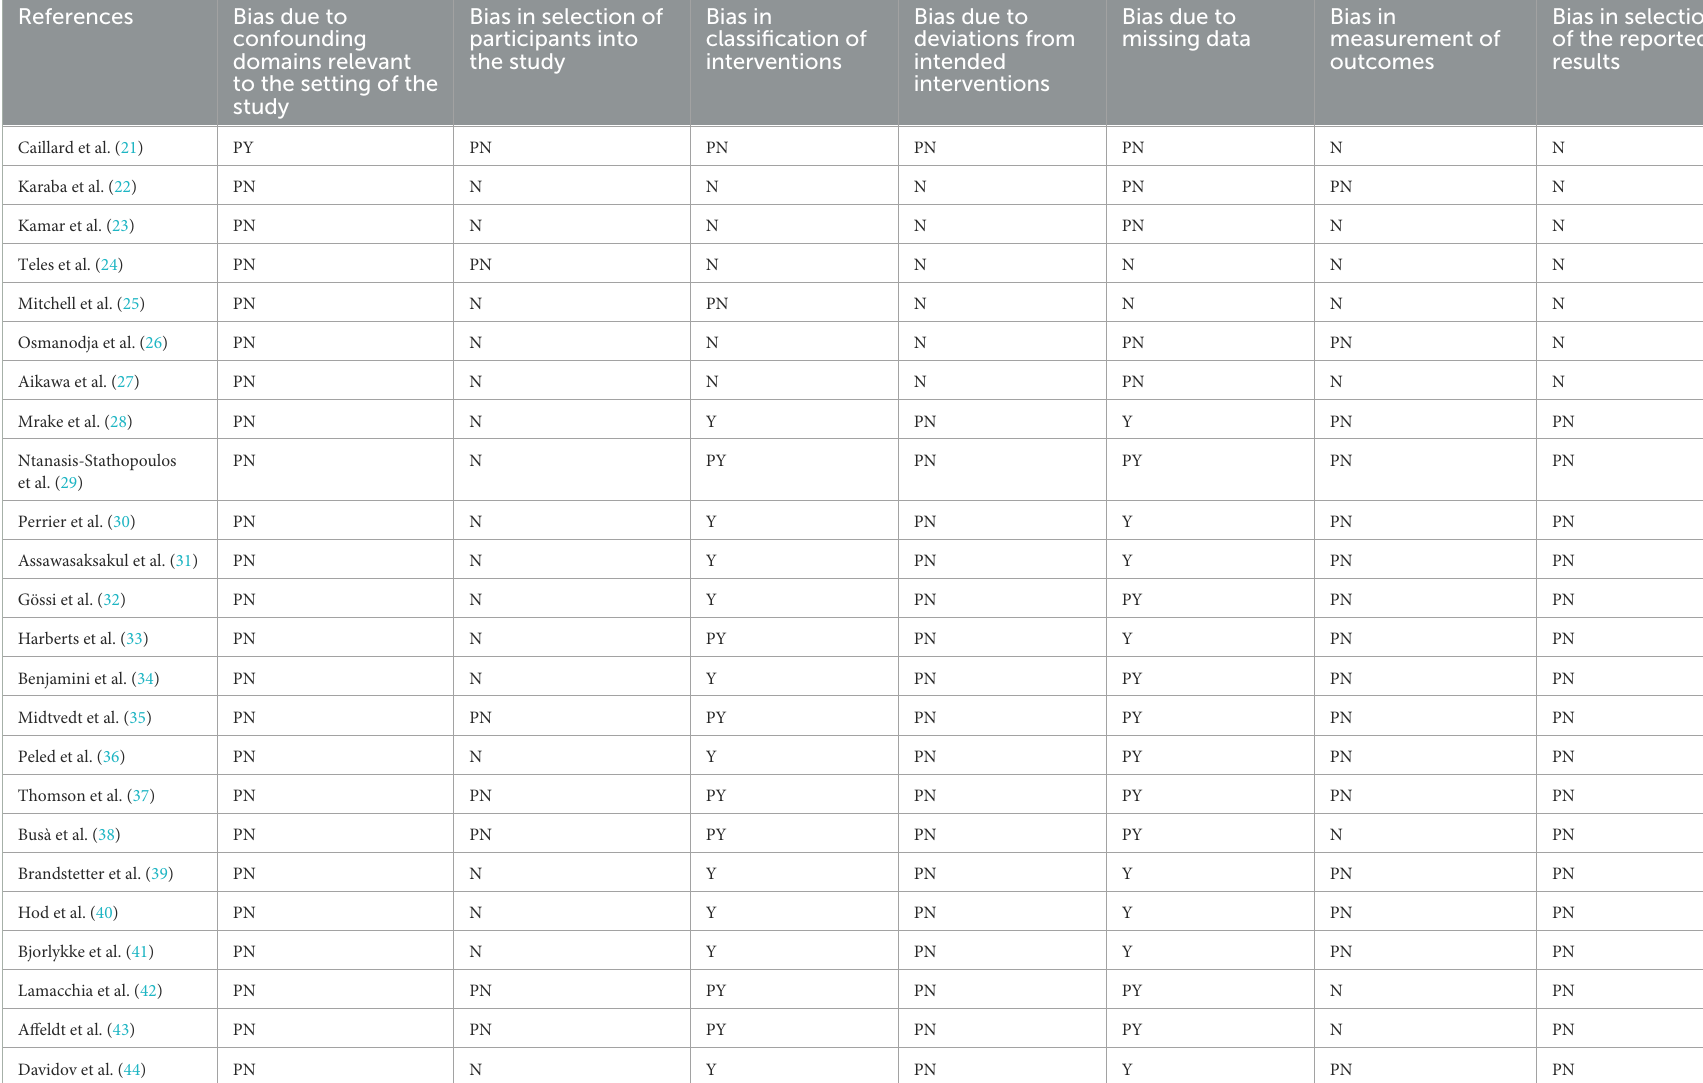
TABLE 1 Methodological quality evaluation of the included non-randomized studies according to